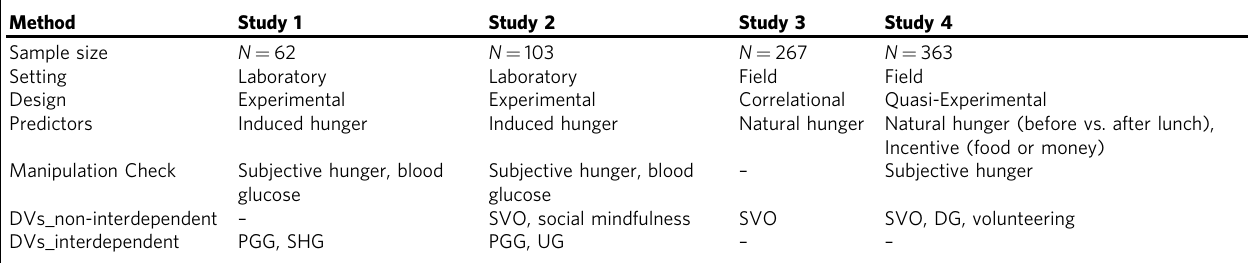
Table 1 Overview of the methods used in Studies 1 – 4, including samples, design, and predictor variables, as well as dependent variables (DVs), either in non-interdependent or interdependent